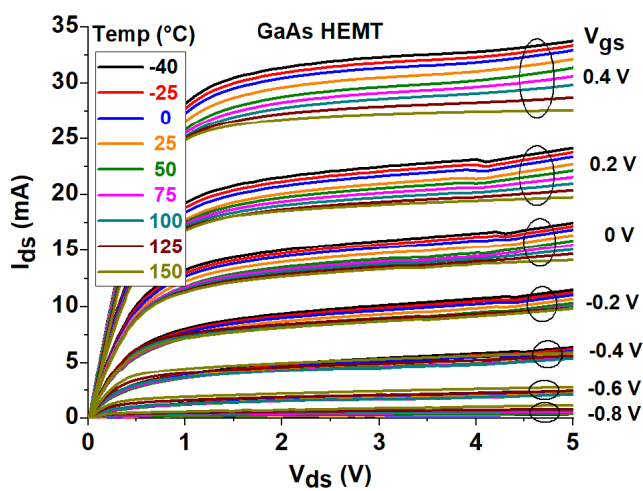
Figure 2. DC output characteristics of the studied GaAs HEMT at different T a .